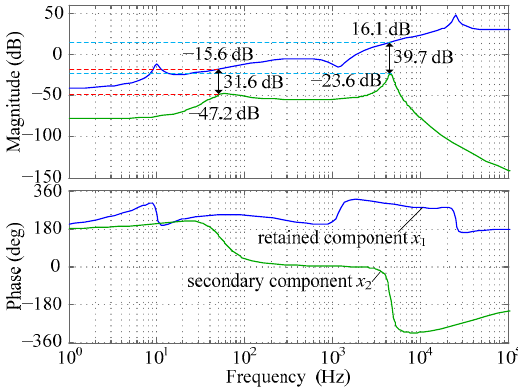
Figure 5. The Bode diagrams of the retained component x 1 and secondary component x 2 .